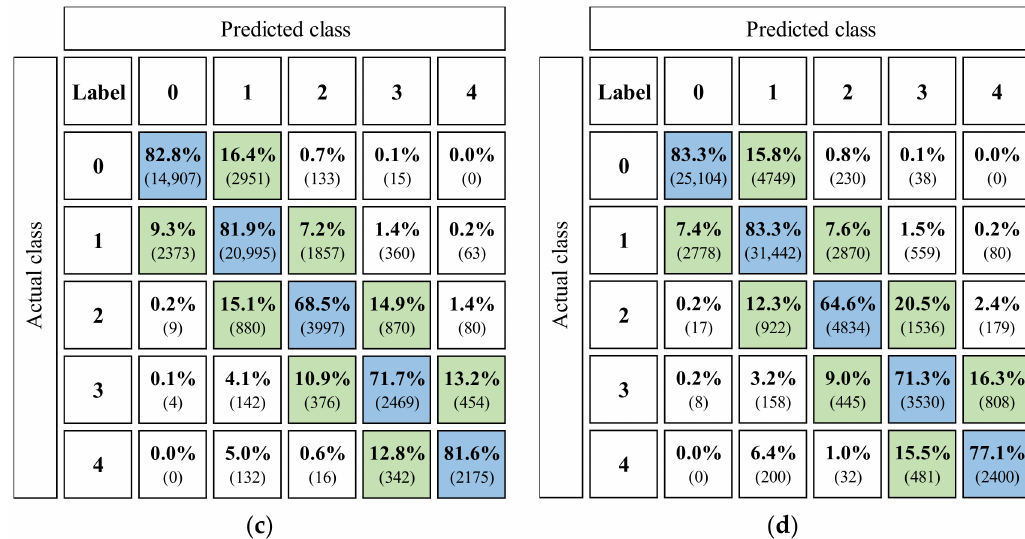
Figure 12. Confusion matrices for buildings with different fundamental periods: ( a ) fundamental period of 0.1–0.3 s (prediction accuracy = 79.4%); ( b ) fundamental period of 0.4–0.5 s (prediction accuracy = 78.2%); ( c ) fundamental period of